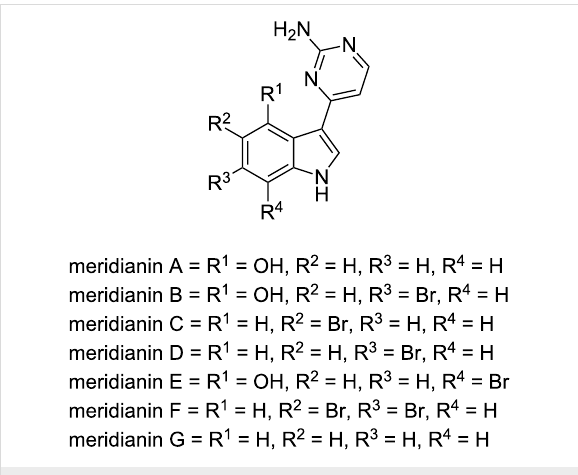
Figure 1: Structure of meridianins A–G.